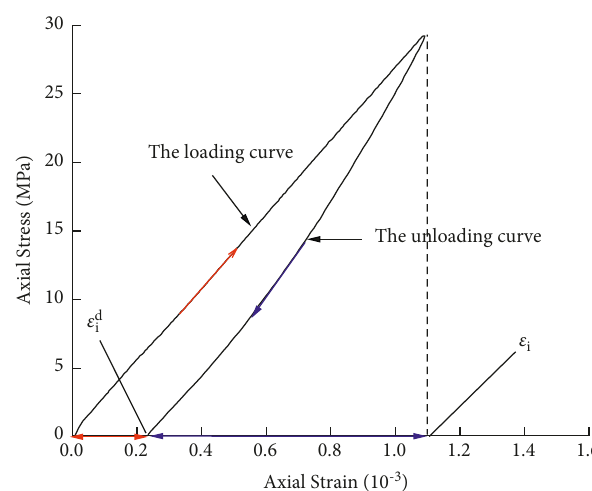
Figure 4: The relationship between elastic energy and dissipated energy of rocks during loading and